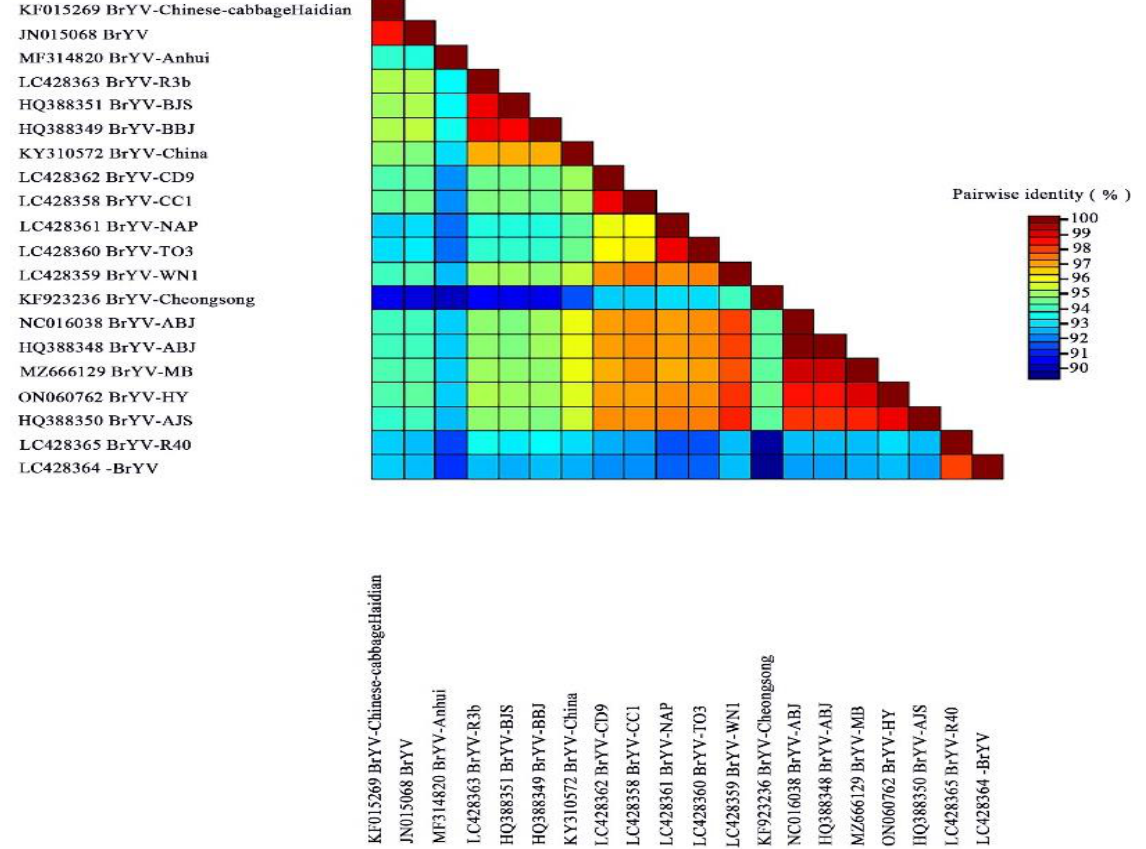
Figure 1. The distribution of pairwise identity scores of the complete genomic sequences of brassica yellows virus (BrYV) isolates was determined using the MUSCLE multiple sequence alignment program in SDT software. Abbreviations and GenBank accession numbers are as follows: BrYV China